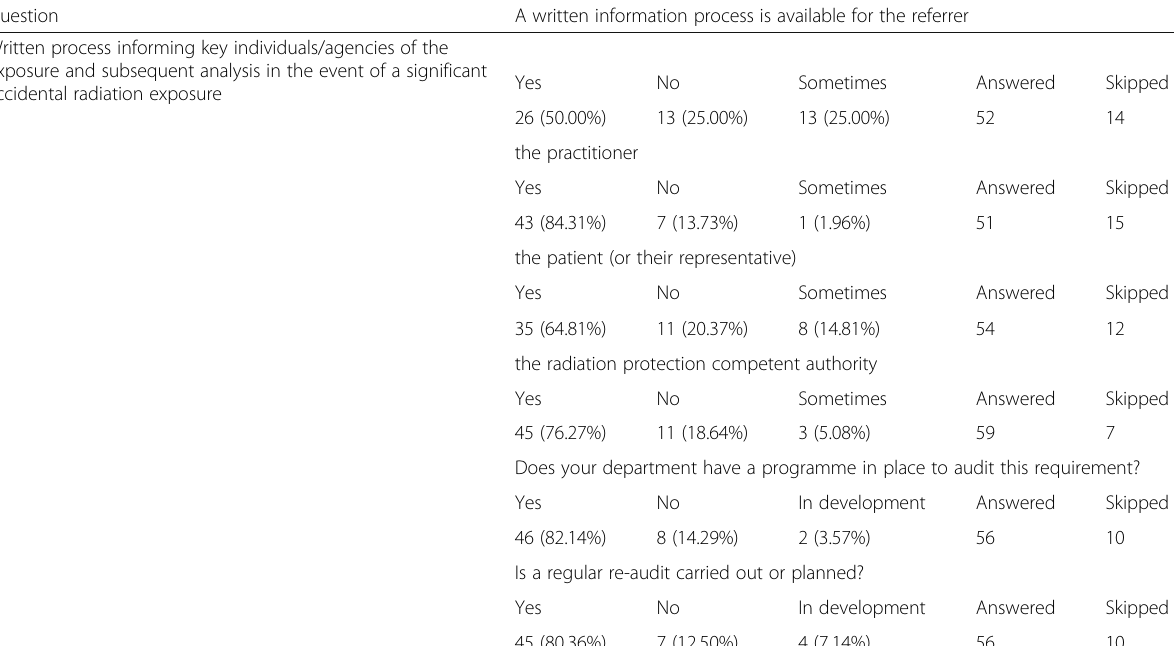
Table 2 Pilot Survey on uptake of European BSS Directive (2013/59 Euratom) requirements with particular focus on clinical audit in European radiology departments Question A written information process is available for the referrer Written process informing key individuals/agencies of the exposure and subsequent analysis in the event of a significant accidental radiation